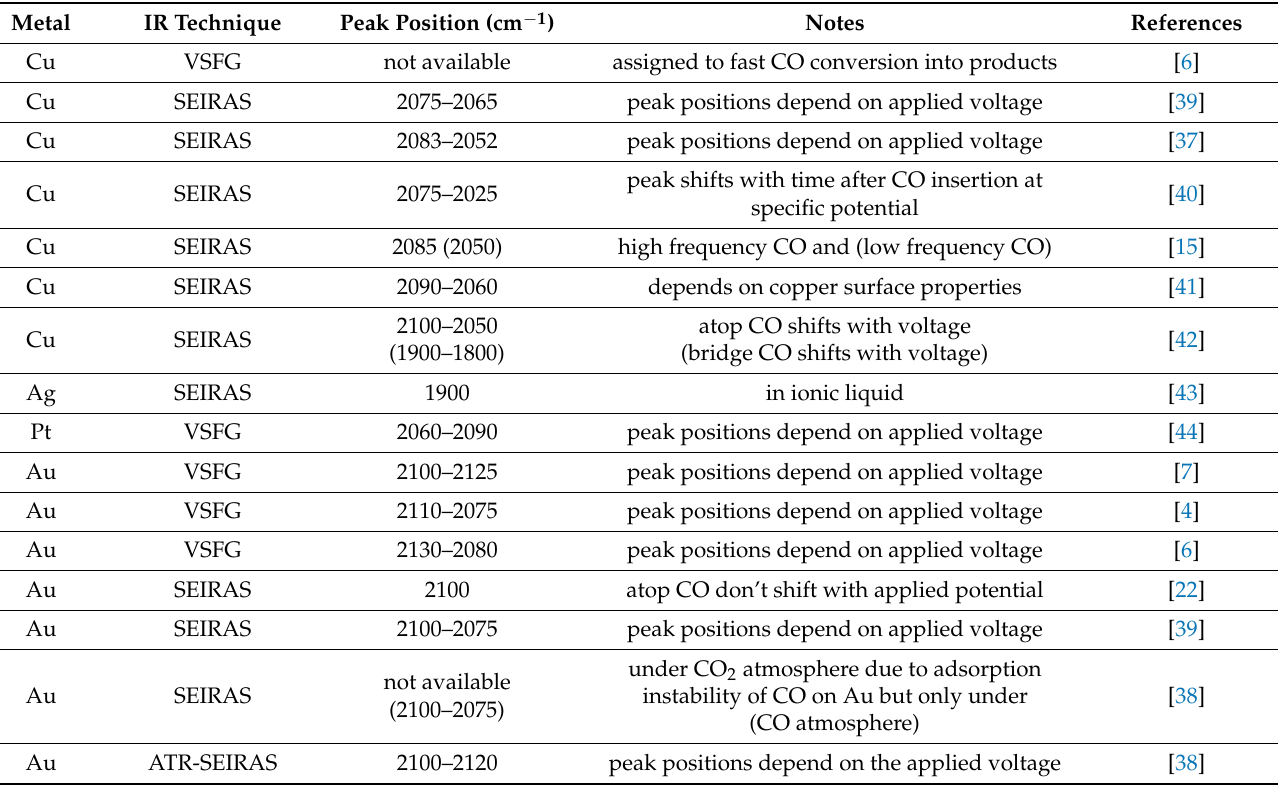
Table 2. Summarized data for the detection of adsorbed CO on metal surfaces using infrared techniques under applied external